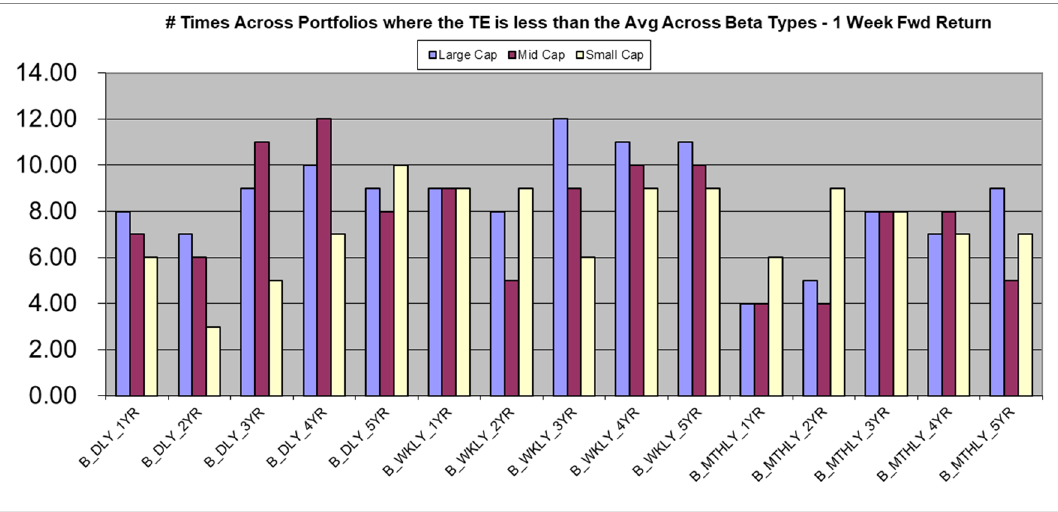
Figure 3. Weekly and daily betas have tracking errors mostly lower than monthly